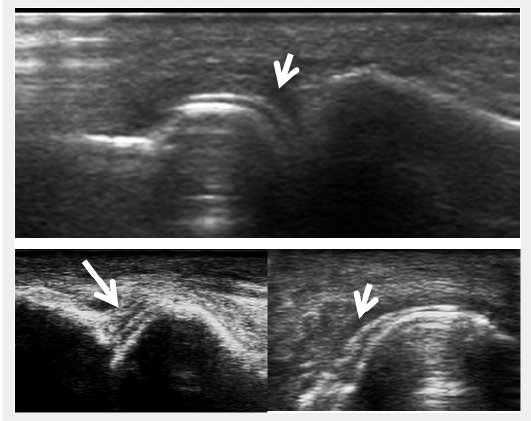
"Double contour" sign in gouty arthritis (white arrows): dorsal view of several metatarso-phalangeal joints performed outside an acute flare of